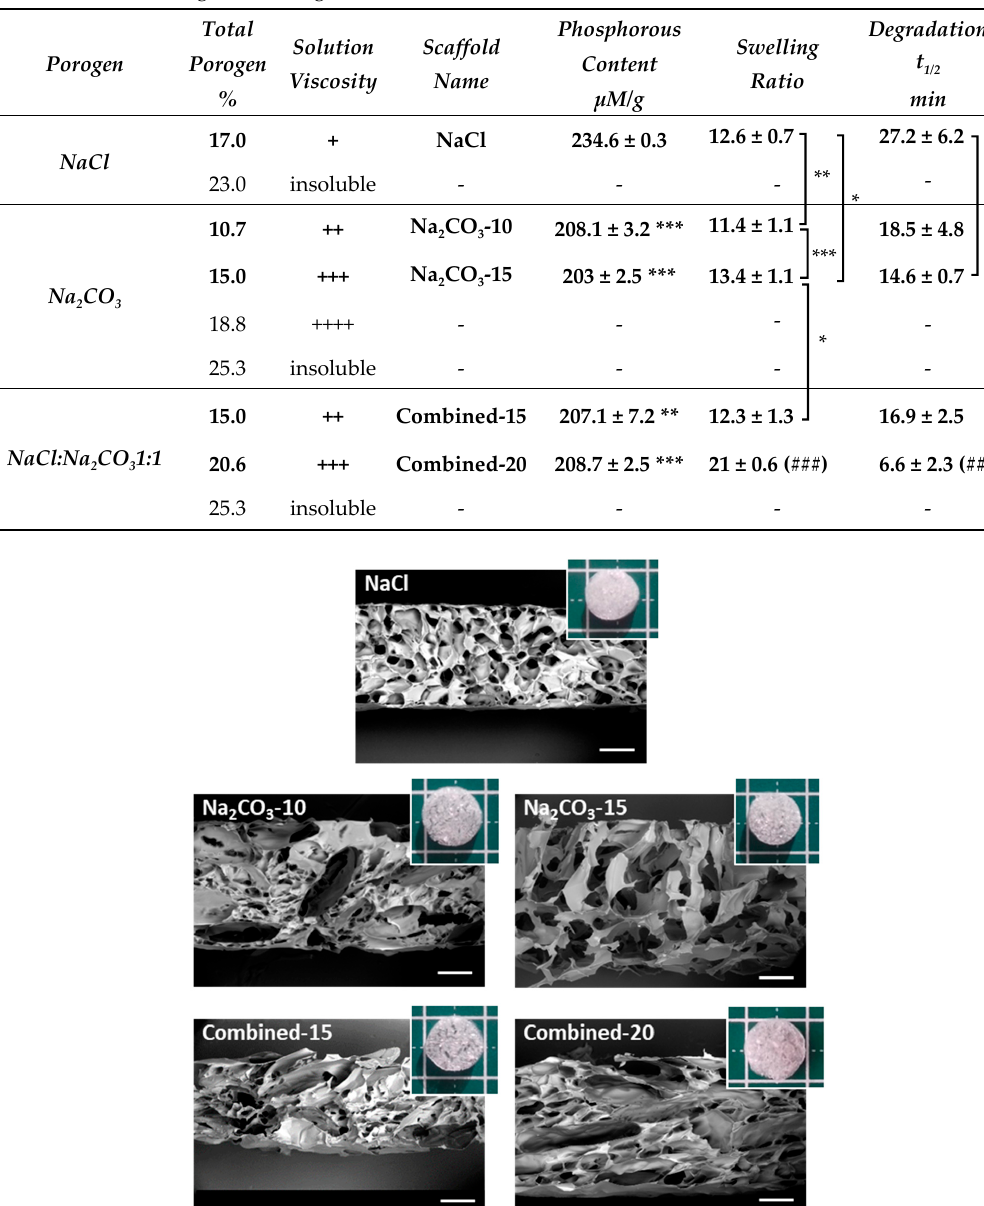
Table 1. Effect of polysaccharide formulations (porogen type and weight amounts) on scaffold production, phosphorous content ( n = 3), swelling ratio ( n > 6) and in vitro enzymatic degradation (t 1/2 , time to degrade 50% of the scaffold weight). Statistical analysis using student t-test. * p < 0.05, ** p < 0.01, *** p < 0.001 denote statistical significance against NaCl scaffold. ## p < 0.01, ### p < 0.001 denote statistical significance against all other scaffolds.